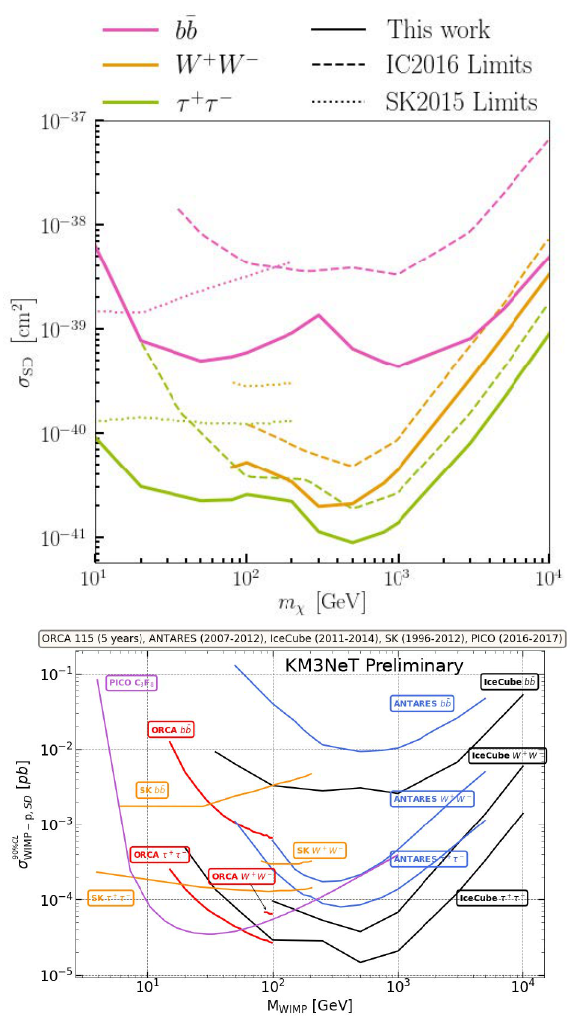
Figure 1. Limits on the spin-dependent WIMP-proton scattering cross section as a function of the WIMP mass for several channels: ( top ) Limits from IceCube [19,20] and SuperK [21] (figure reproduced from [19], credit: IceCube collaboration); ( bottom ) Limits from ANTARES [22] and sensitivity (for five years) for KM3NeT-ORCA [23]; limits from IceCube (3 years of data) [24], SuperK [21] and PICO [25] are also shown (figure reproduced from [23], credit: ANTARES and KM3NeT